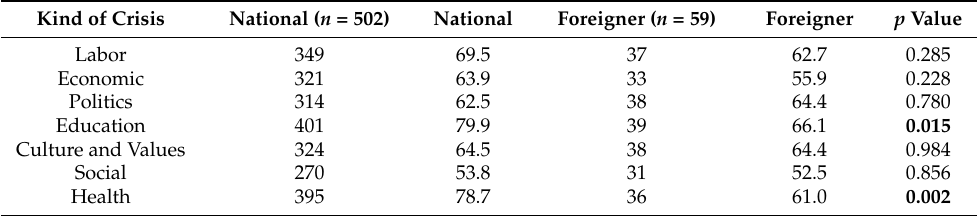
Table 4. Distribution of the sample by type of resident according to type of